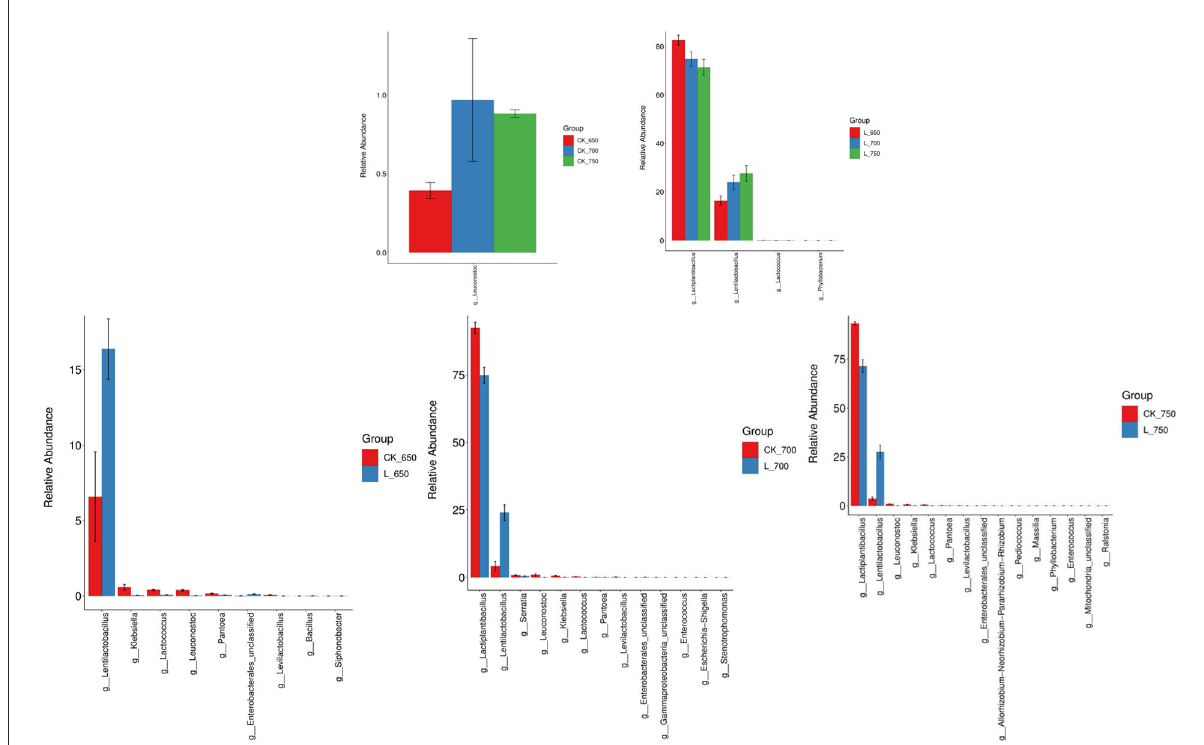
FIGURE3 Difference in bacterial communities (genus level) in sweet sorghum silages ( n = 4). CK, ensiling of sweet sorghum with 2.00 mL/kg fresh weight (FW) of distilled water at 650 (CK_650), 700 (CK_700), and 750 kg/m 3 (CK_750) of density, respectively; L, ensiling of sweet sorghum with 2.00 g/t FW of lactic acid bacteria (LAB) inoculant and 2.00 mL/kg FW of distilled water at 650 (L_650), 700 (L_700), and 750 kg/m 3 (L_750) of density, respectively.